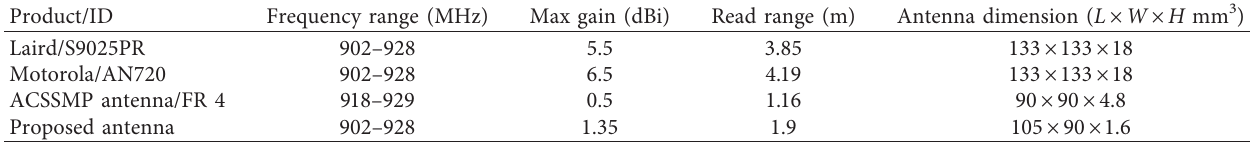
Table 3: Proposed antenna vs. existing product parameters.